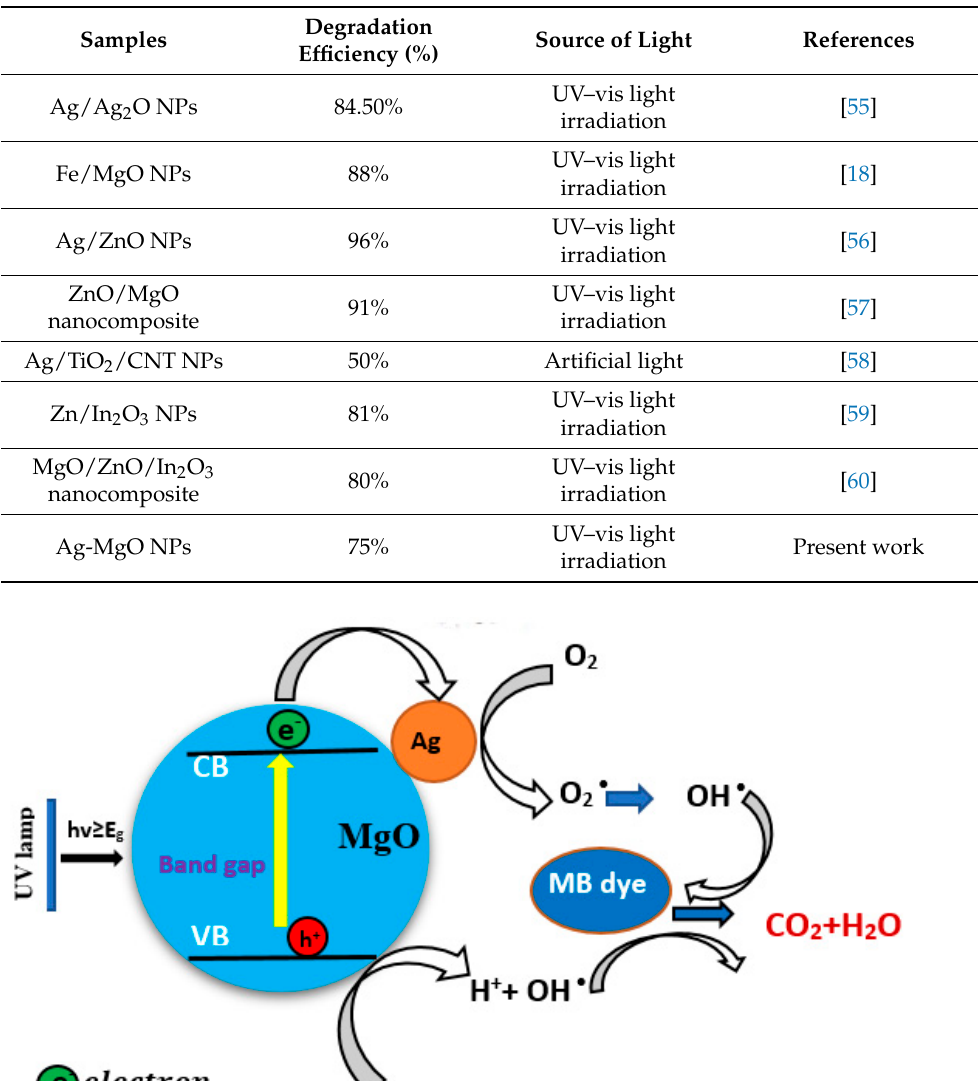
Table 2. Comparison of degradation efficiency for various samples on MB dye.